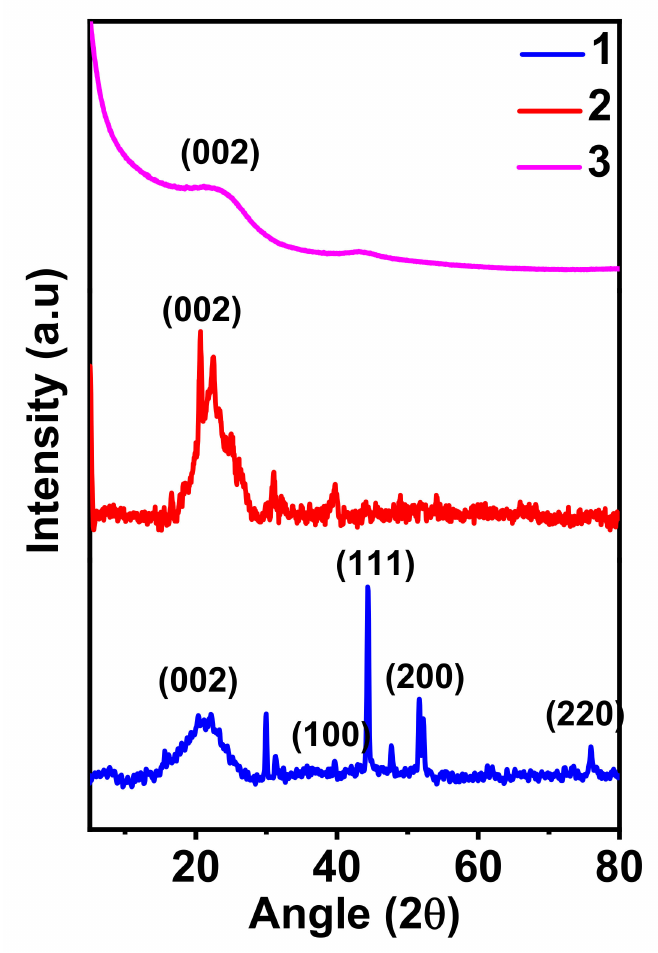
Figure 4. Powder X-Ray diffraction patterns of nanocomposites (1), (2) and